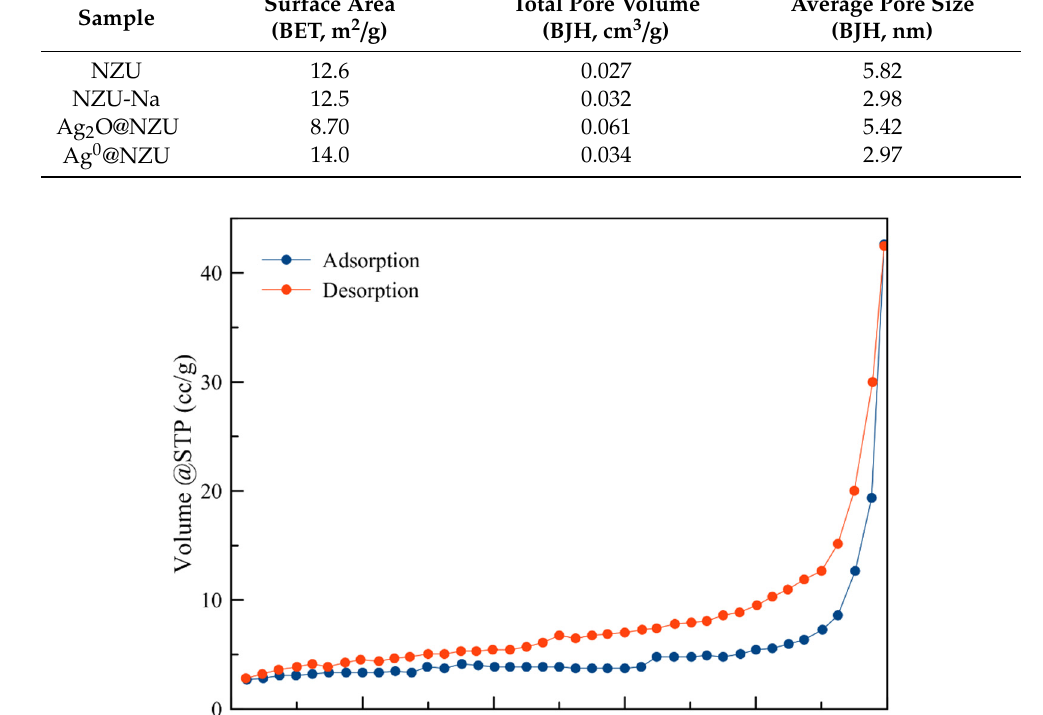
Figure 1. XRD patterns of Ag 0 @NZU, Ag 2 O@NZU and NZU ‐ Na.